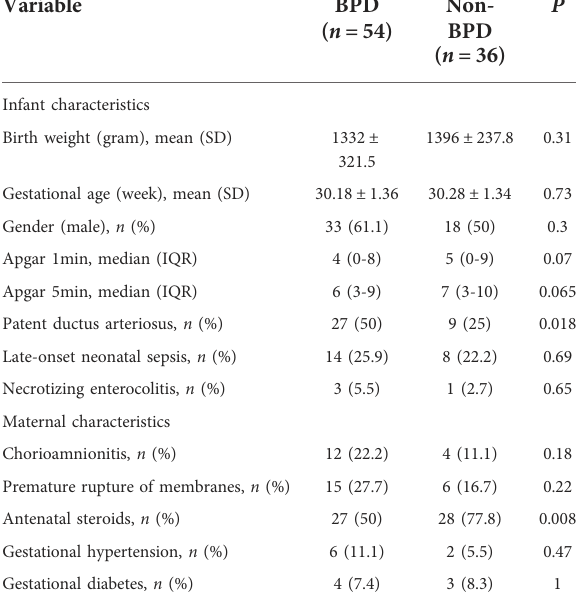
TABLE 1 Baseline characteristics of included 90